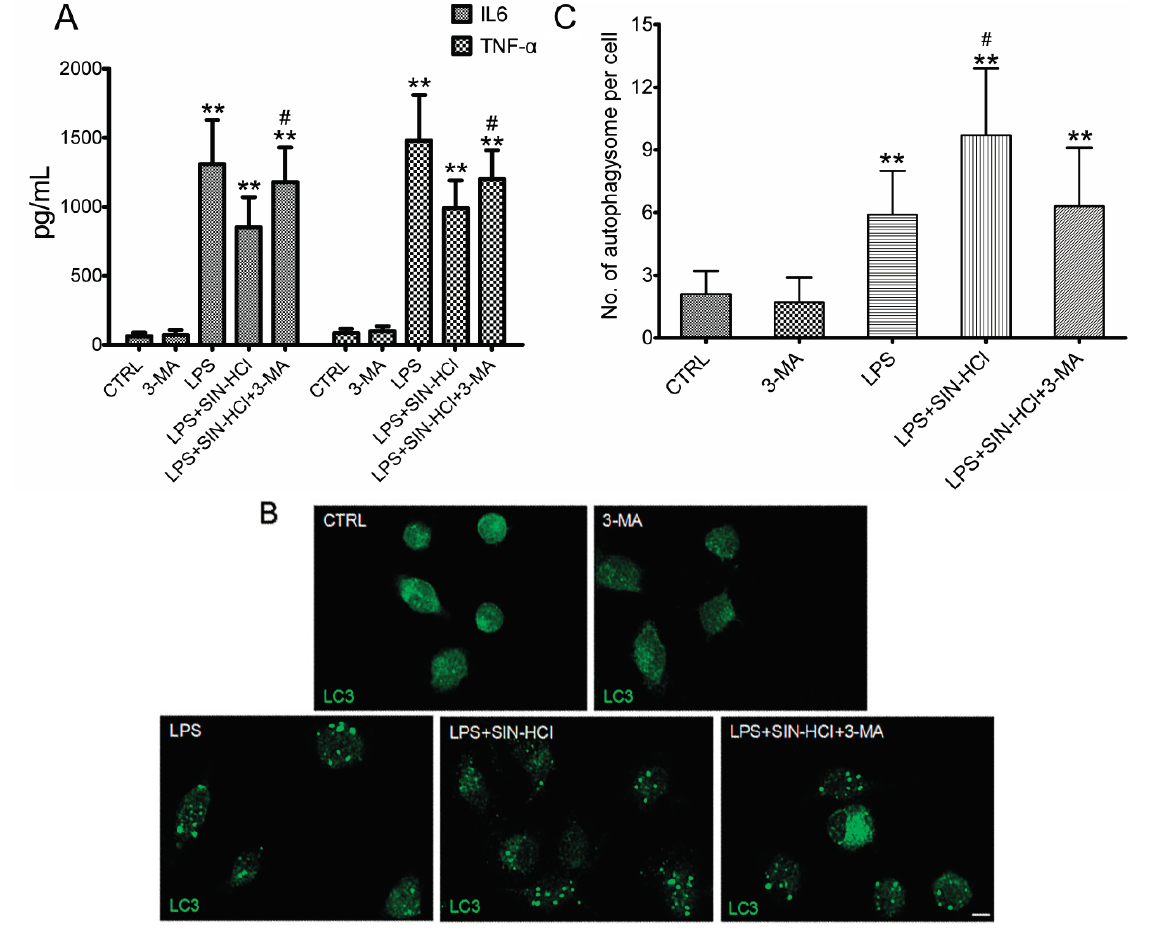
Figure 5. The effects of 3-MA on SIN-HCl-induced autophagy and inflammatory responses in PM. ( A ) Primary PM were cultured for 12 h with 3-MA (5 mM), LPS (100 ng/mL), SIN-HCl (100 mM), or a combination of these two reagents (as indicated). The levels of IL-6 and TNF- α in culture media were measured. ** p < 0.01 when compared with PBS group, n ≥ 6; # p < 0.05 when compared with the LPS group, n ≥ 6; ( B ) Primary PM were treated with 3-MA (5 mM), LPS (100 ng/mL), SIN-HCl (100 mM), or a combination of these reagents (as indicated) for 12 h before immunofluorescent detection of LC3 protein using an anti-LC3 antibody. Scale bar = 10 μ m; ( C ) Autophagosomes in at least 30 PM cells were counted. Scale bar was equivalent to 10 μ m. ** p < 0.01 when compared with PBS group, n ≥ 4; # p < 0.05 when compared with the LPS group, n ≥